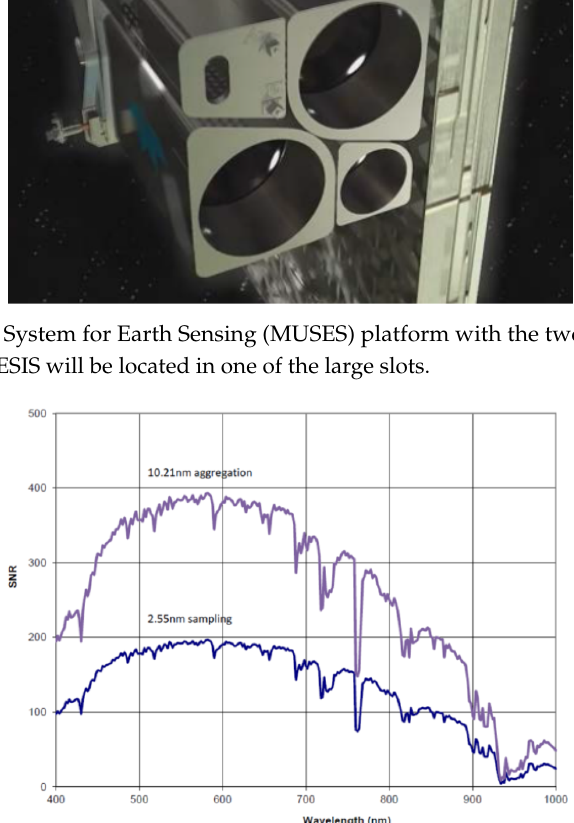
Figure 2. The Signal-to-Noise Ratio (SNR) for spectral sampling without binning (2.55nm, blue) and binning mode 4 (10.21nm, purple) at 232Hz. Simulation based on MODTRAN (MODerate resolution atmospheric TRANsmission) with standard mid-latitude summer atmosphere (Albedo 0.3) and solar zenith angle of